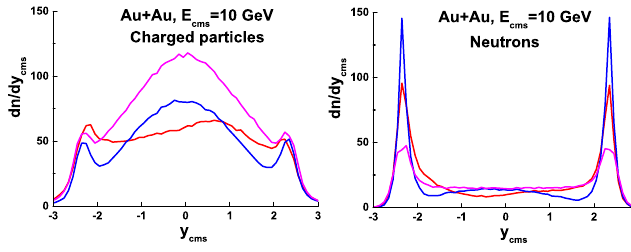
Figure 5. Rapidity distribution of charged particles (left) and neutrons (right) produced in Au + Au interactions at NN center of mass energy 10 GeV. Blue, red, violet lines are calculations by the FTFP, QGSM (Shield version), UrQMD 1.3, correspondingly